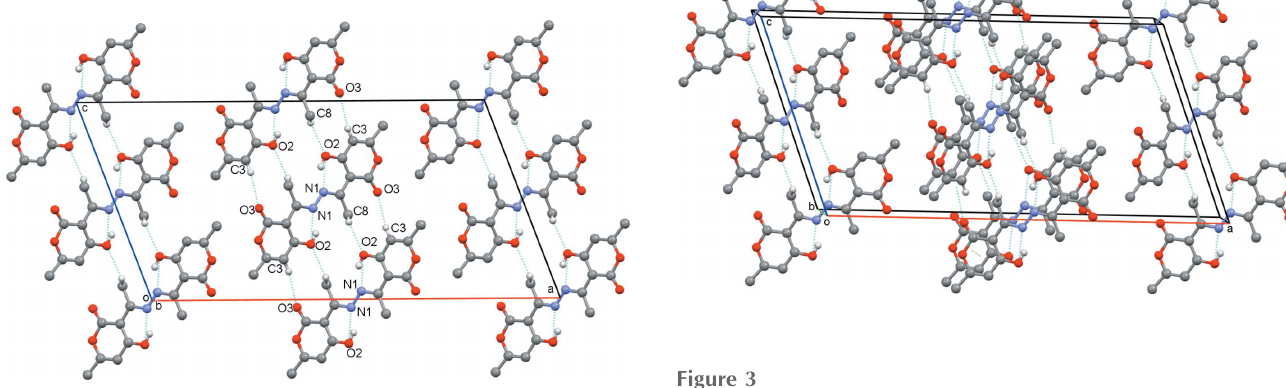
Figure 2 Projection of the title structure along (010), showing molecules connected by hydrogen bonds (dashed cyan lines). For clarity, only H atoms involved in these interactions have been included.